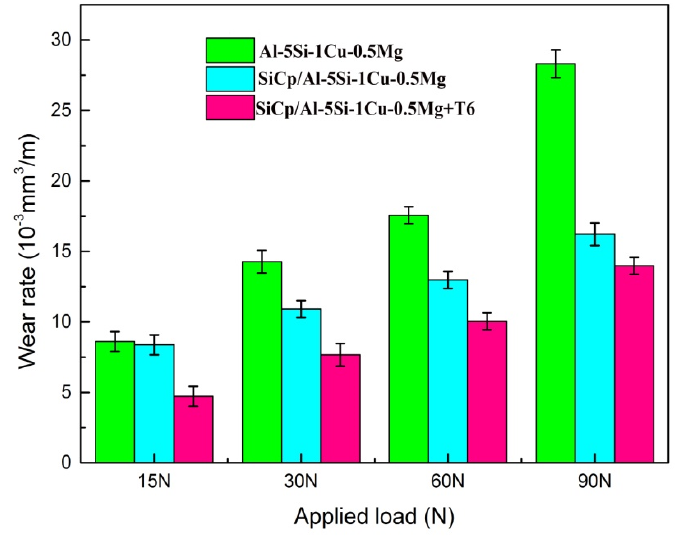
Figure 5. Wear rate values for samples under various applied loads.